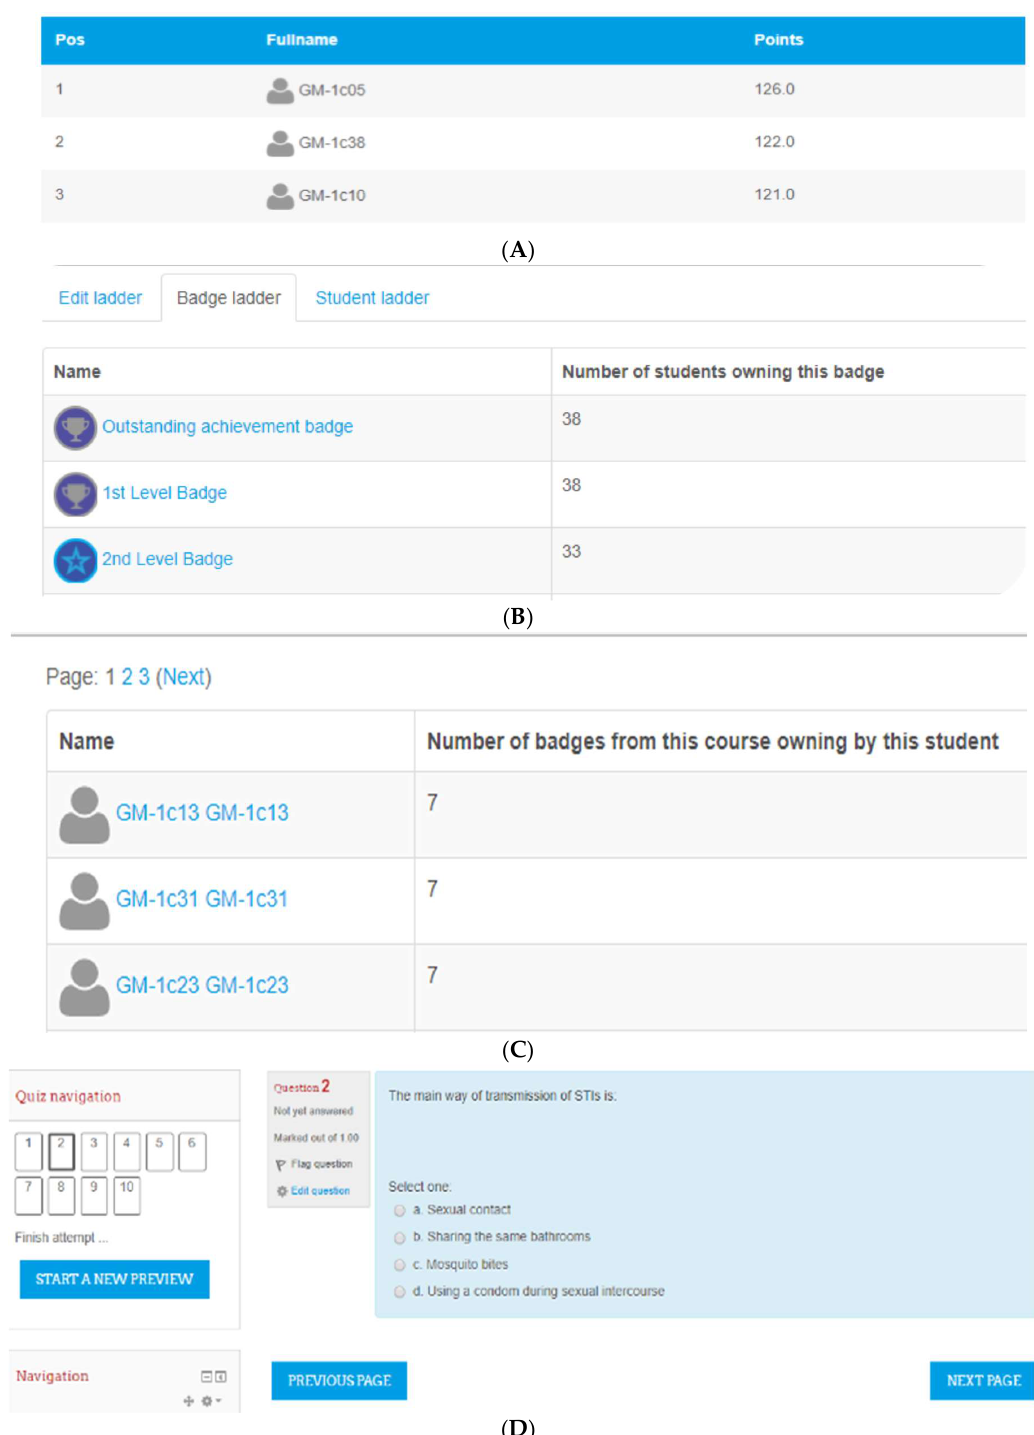
Figure 3. Game mechanics used in the gamification condition. ( A ) Leaderboards; ( B ) Badges; ( C ) Badges counter; ( D ) Quiz.